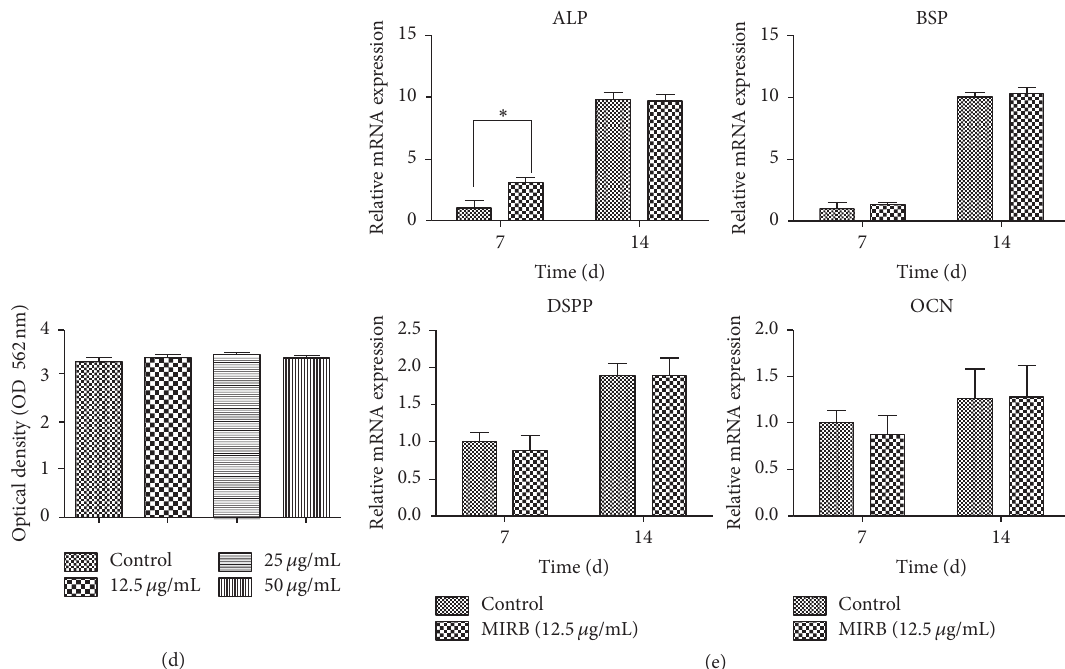
Figure 5: Odonto-/osteogenic differentiation analysis on MIRB-labeled and unlabeled hDPSCs. (a) Images of the ALP staining in labeled and unlabeled groups after 7 and 14 days of osteogenic induction. (b) Quantitative results of ALP staining. (c) Images of the mineral deposits of the labeled and unlabeled hDPSCs after 14 days of osteogenic induction. (d) Quantitative results of Alizarin Red staining. The scale bar indicates 100 𝜇 m. (e) Expression of ALP, BSP, DSPP, and OPN by hDPSCs after 7 and 14 days of osteogenic induction. ∗ 𝑃 < 0.05